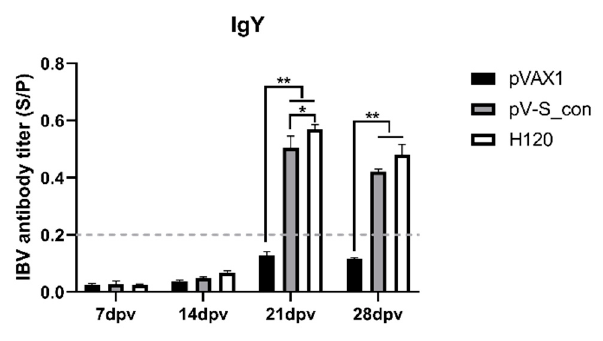
Figure 5. IBV-specific antibodies in the serum. The antibody titers are shown as mean sample vs. positive control (S/P) values + SEM of each group. The threshold cut-off values of the IBV ELISA were 0.2. S/P = (Sample A (650) − NC(negative control) A (650))/(PC (positive control) A (650) − NC A (650)). Tukey’s multiple comparison test was used for statistical analysis; * p < 0.05, ** p < 0.01.